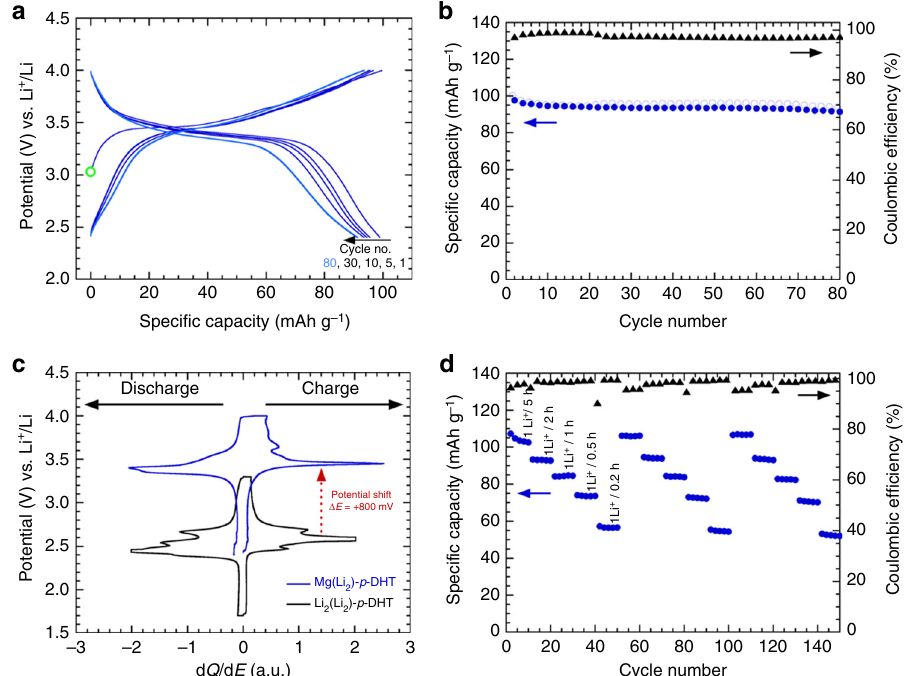
Fig. 4 Charge/discharge electrochemical performance of Mg(Li 2 )- p -DHT electrode material vs. Li. a Potential vs. speci fi c capacity curve (cycle nos. 1, 5, 10, 30 and 80) of a Li half-cell using Mg(Li 2 )- p -DHT as the active electrode material, mixed with 33 wt.% Ketjenblack EC-600JD (no binder) and galvanostatically cycled at a rate of 1 Li + /5 h ( I = 23 mA g − 1 ) LiPF 6 1 M in EC/DMC as the electrolyte. Note that the green circle indicates the starting open circuit potential ( E I = 0 ≈ 3.1 V vs. Li + /Li), which is notably higher than that of Li 4 - p -DHT ( E I = 0 ≈ 2.5 V vs. Li + /Li) 47 . b Corresponding capacity retention curve, together with the coulombic ef fi ciency. c Superimposition of the potential vs. differential capacity curves (second cycle) for both Mg(Li 2 )- p -DHT (blue) and Li 4 - p -DHT (black) cycled vs. Li. The red arrow marks the positive potential shift. d Speci fi c capacity vs. cycle number for current rate changes ranging from 1 Li + /5 h to 1 Li + /0.2 h per series of 10 cycles (repeated three